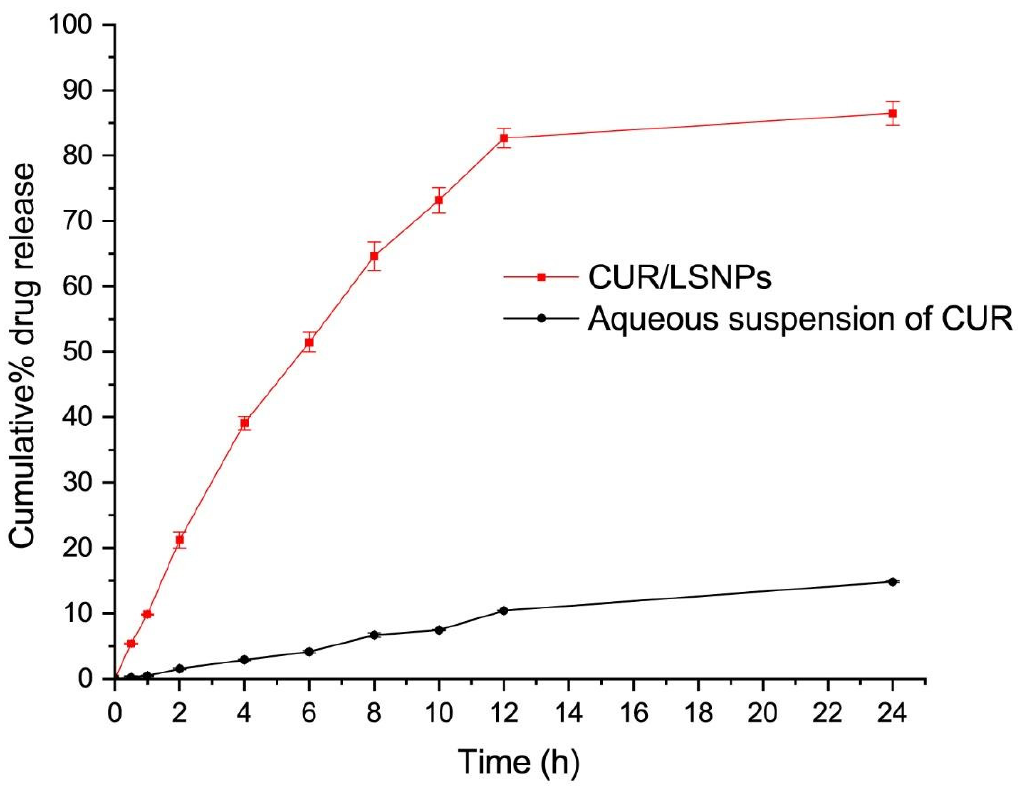
Figure 6. Cumulative percentage of the drug released from optimized CUR/LCSNPs in comparison to the aqueous suspension of the CUR.